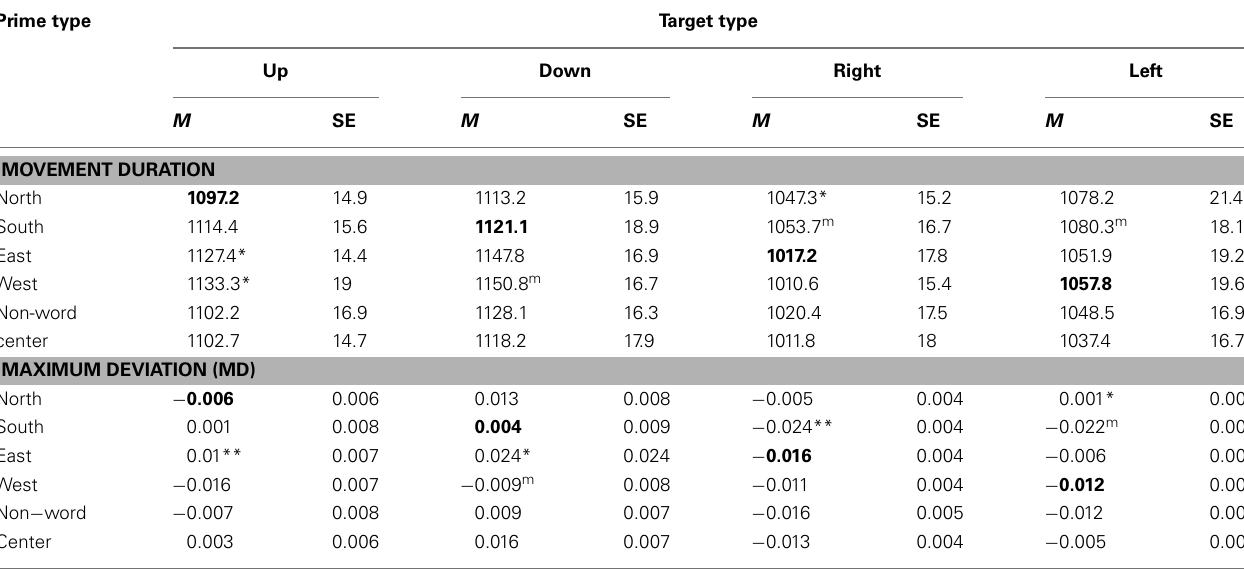
Table 2 | Experiment 2 mean and standard error movement duration and maximum deviation (MD) data for each of the six prime types and four target